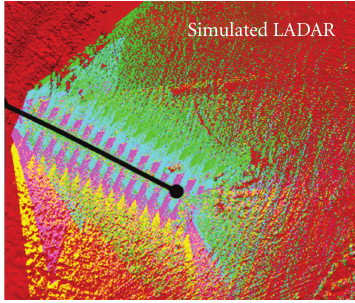
Figure 4: Overhead view of the simulated scene and simulated LIDAR point cloud data for the four forward-facing LIDAR sensors and the path traveled by the sensors. Points for each sensor are colored di ff erently and the ground surface is colored in red (best viewed in